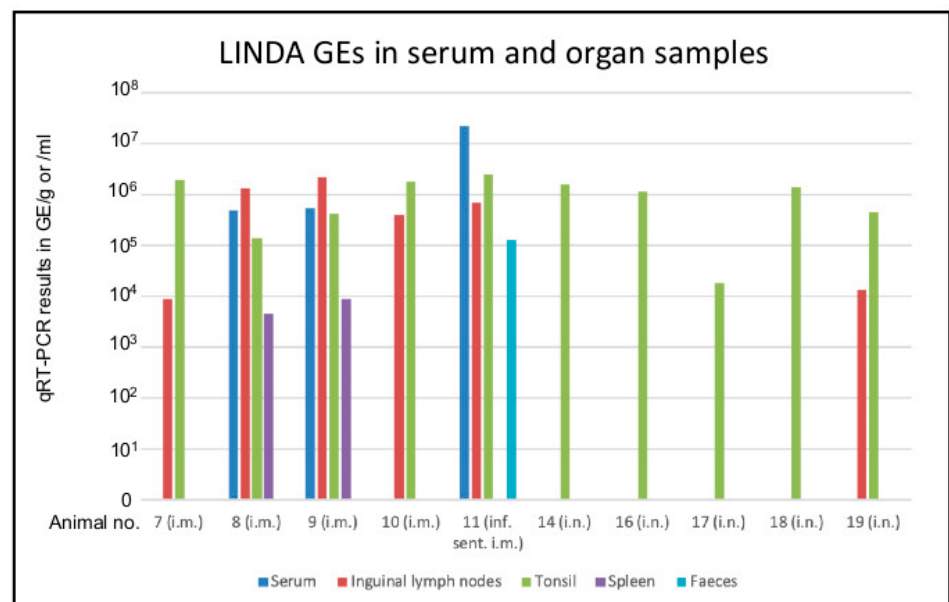
Figure 3. qRT-PCR results of the animal experiment. Multiple samples were analyzed for the presence of LINDA RNA before, during and after the experimental infection of piglets with LINDA. Blood and fecal samples as well as nasal and oral swabs were taken on study days 0, 3, 5, 7, 14, 21 and 28 / 29. Fecal samples were collected on study days 3, 7 and 14, while urine samples were only taken from most animals on day 3. Kidney, bladder, cerebellum, cerebrum, spinal cord, dorsal root ganglia, thymus, spleen, tonsils, di ff erent lymph nodes (Lnn. inguinales, mesenteriales and mandibularis), parotid and sublingual glands, heart, lung, liver and intestinal segments were sampled from all animals during necropsy on days 28 / 29. Most samples gave negative results for LINDA RNA. Only two i.m. infected animals showed detectable LINDA RNA loads in serum samples taken on study day 7 and one sentinel animal of the i.m. group on day 14. These serum samples also allowed the re-